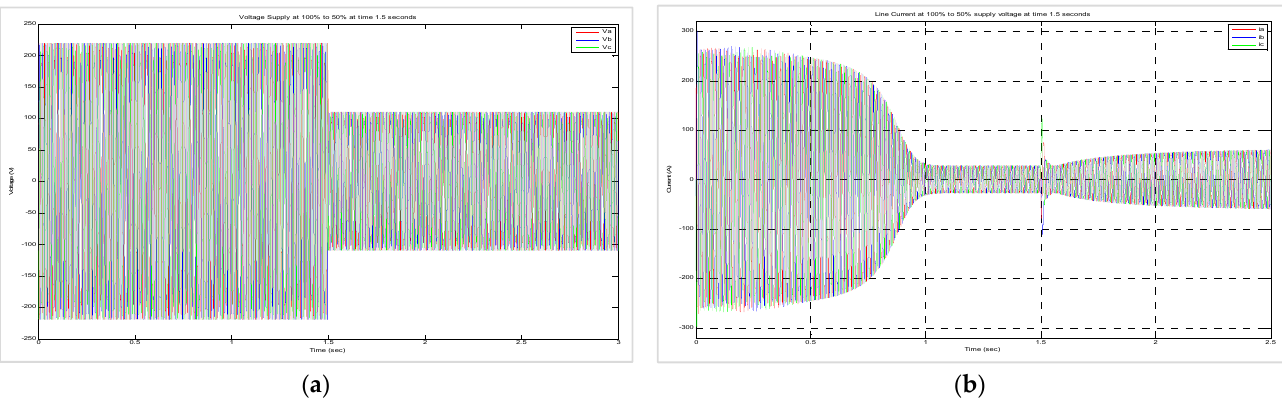
Figure 25. ( a ) The change in the voltage supply from 100% to 50% at 1.5 s. ( b ) Line current when the voltage changes from 100% to 50% at 1.5 s.